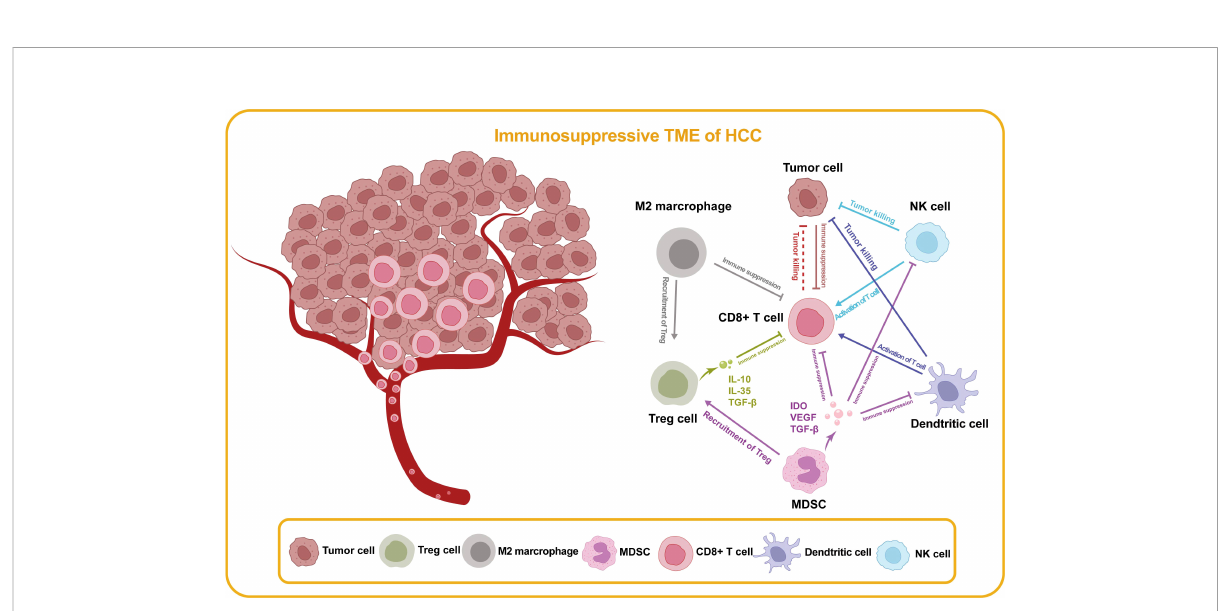
FIGURE 4 Immunosuppressive TME of HCC. In the TME of HCC, there are cell types that promote anti-tumor immunity and cell types that impede effective immune surveillance, which are illustrated in this fi gure. Treg cell, regulatory T cell; MDSC, myeloid-derived suppressor cell; NK, natural killer; IDO, indoleamine 2,3-dioxygenase; VEFG, vascular endothelial growth factor; TGF- b , transforming growth factor- b